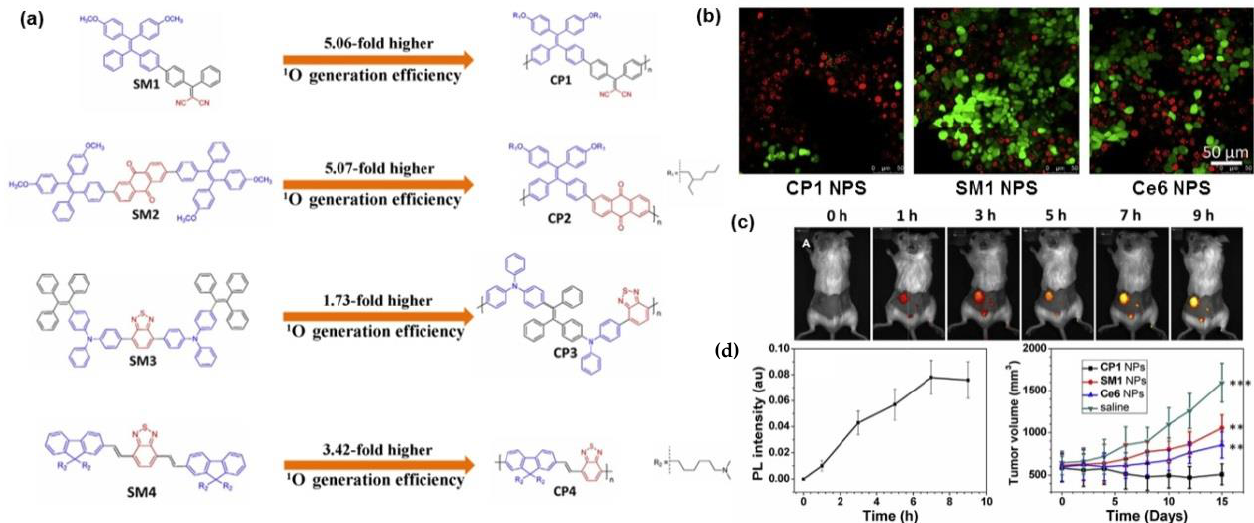
Figure 7. ( a ) The comparison of the working mechanism of photosensitizers between small molecules and conjugated polymers. ( b ) The chemical structures of small molecules SM1–SM4 and conjugated polymers CP1–CP4 with enhanced 1 O 2 generation efficiency. ( c ) Comparative photographs of the effects of PDT based on CP1 NPS, SM1 NPS, and Ce6 NPS at the cellular level. ( d ) Photographs of CP1, SM1, and Ce6 NPs for in vivo image-guided PDT. *** p < 0.001, ** p < 0.01. Reprinted with permission from Ref. [30]. 2018,